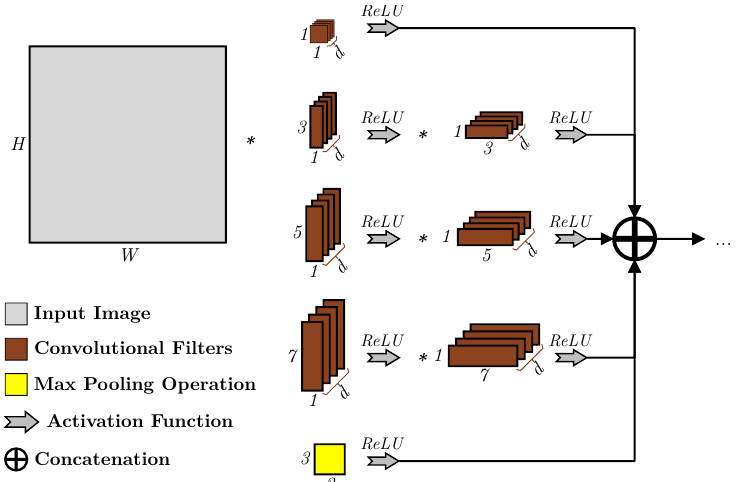
5 with two stacked 3 3 ˆ ˆ × ×